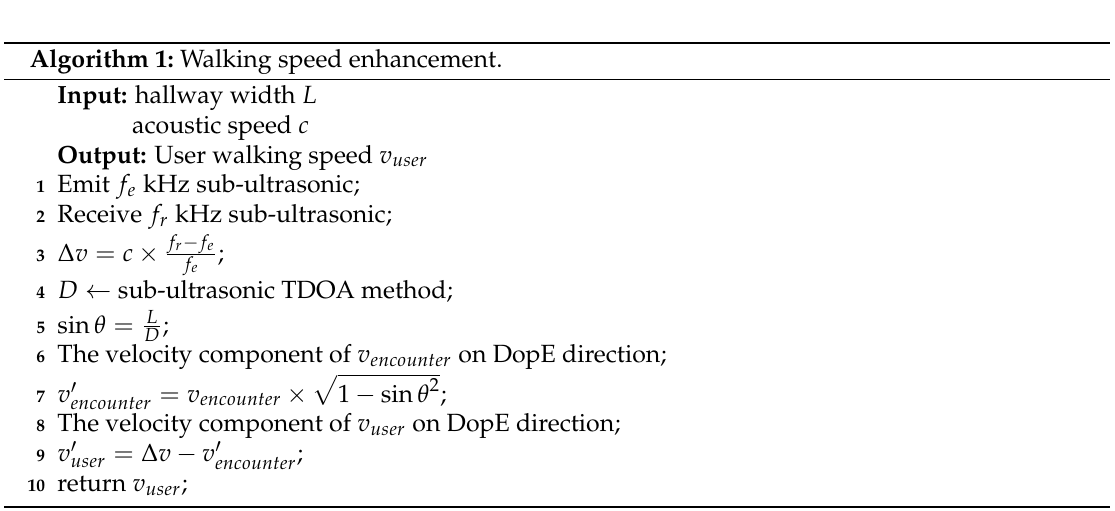
Algorithm 1: Walking speed